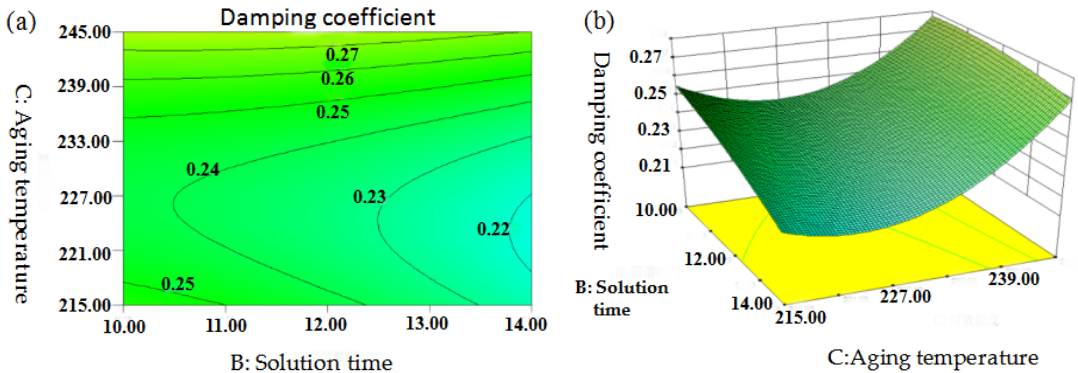
coefficient. ( a ) contour map; (b ) surface response map.